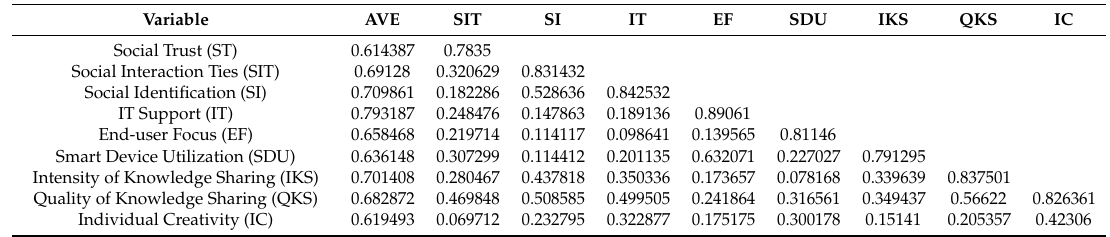
Table 2. Discriminant validity: correlations and average variance extracted (AVE).